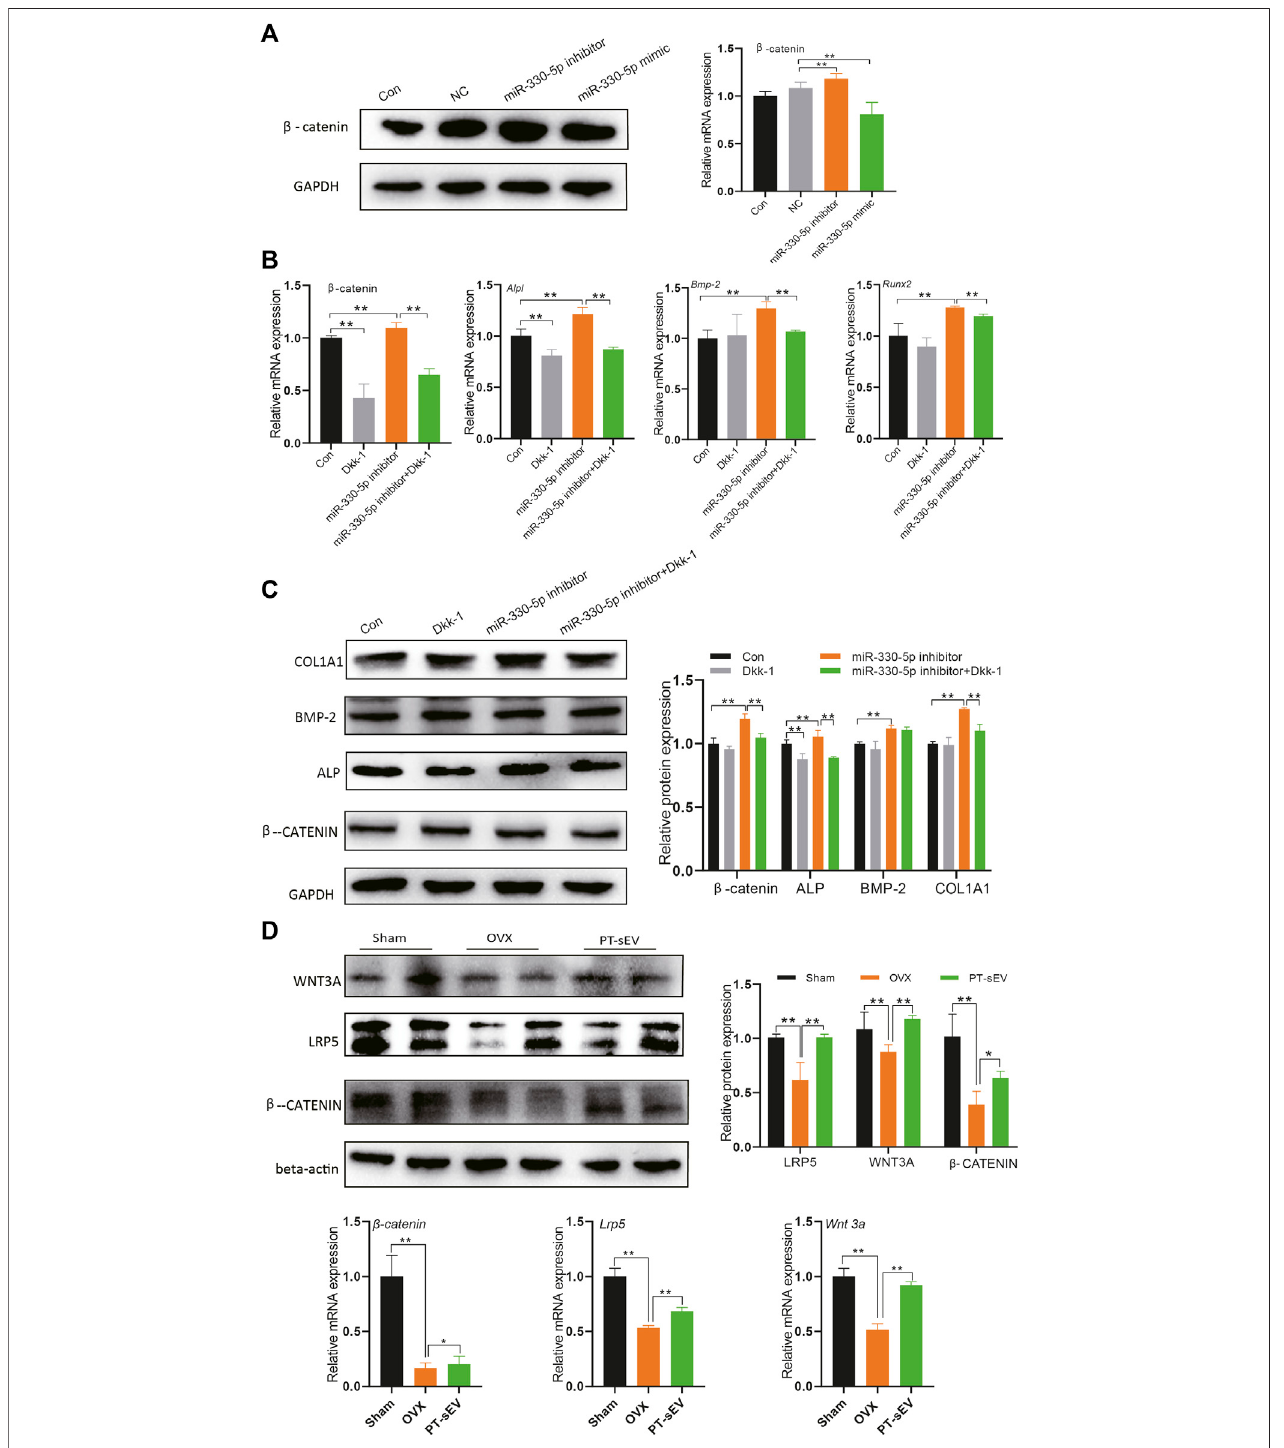
FIGURE7| miR-330 – 5pmediatedWntsignalingtoregulatetheosteogenicdifferentiationofpre-osteoblasts. (A) The β -cateninexpressionwhenoverexpressedor inhibited miR-330 – 5p, the normalized data represented the mean ± SD; (B) The rescue experiments showed the protein expression of osteogenic related factors and β -catenin, the normalized data represented the mean ± SD; (C) The rescue experiments showed the mRNA expression of osteogenic related factors and β -catenin, the normalized data represented the mean ± SD; (D) The Wnt signaling related factor expression in the femur, the normalized data represented the mean ± SD. * p < 0.05, ** p < 0.01, analyses were done twice and obtained comparable